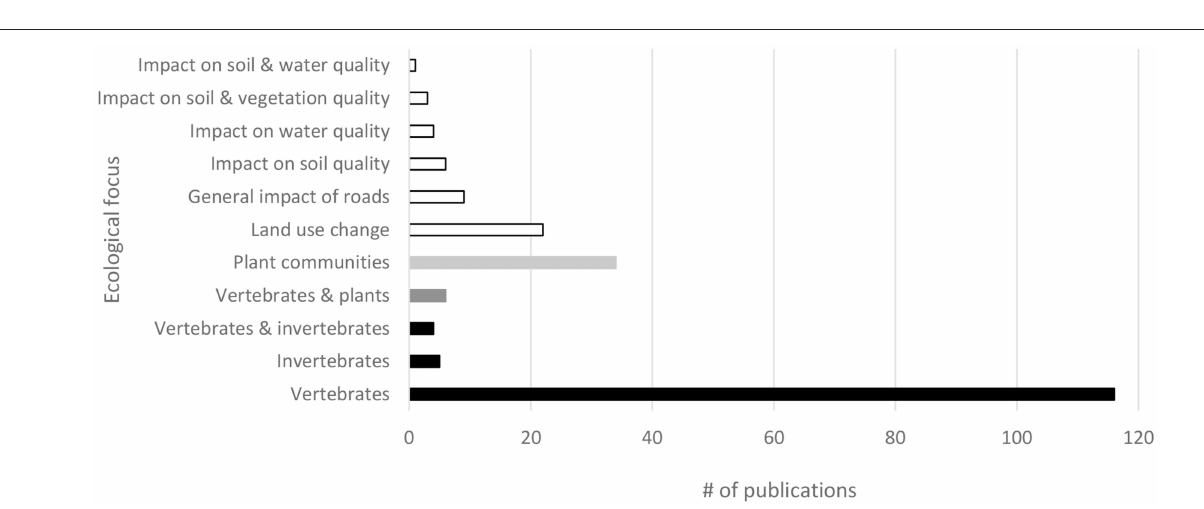
( n = 3) were for other surfaces (e.g., sand and off-road). Only 20% ( n = 42) of publications measured traffic volume and/or vehicle